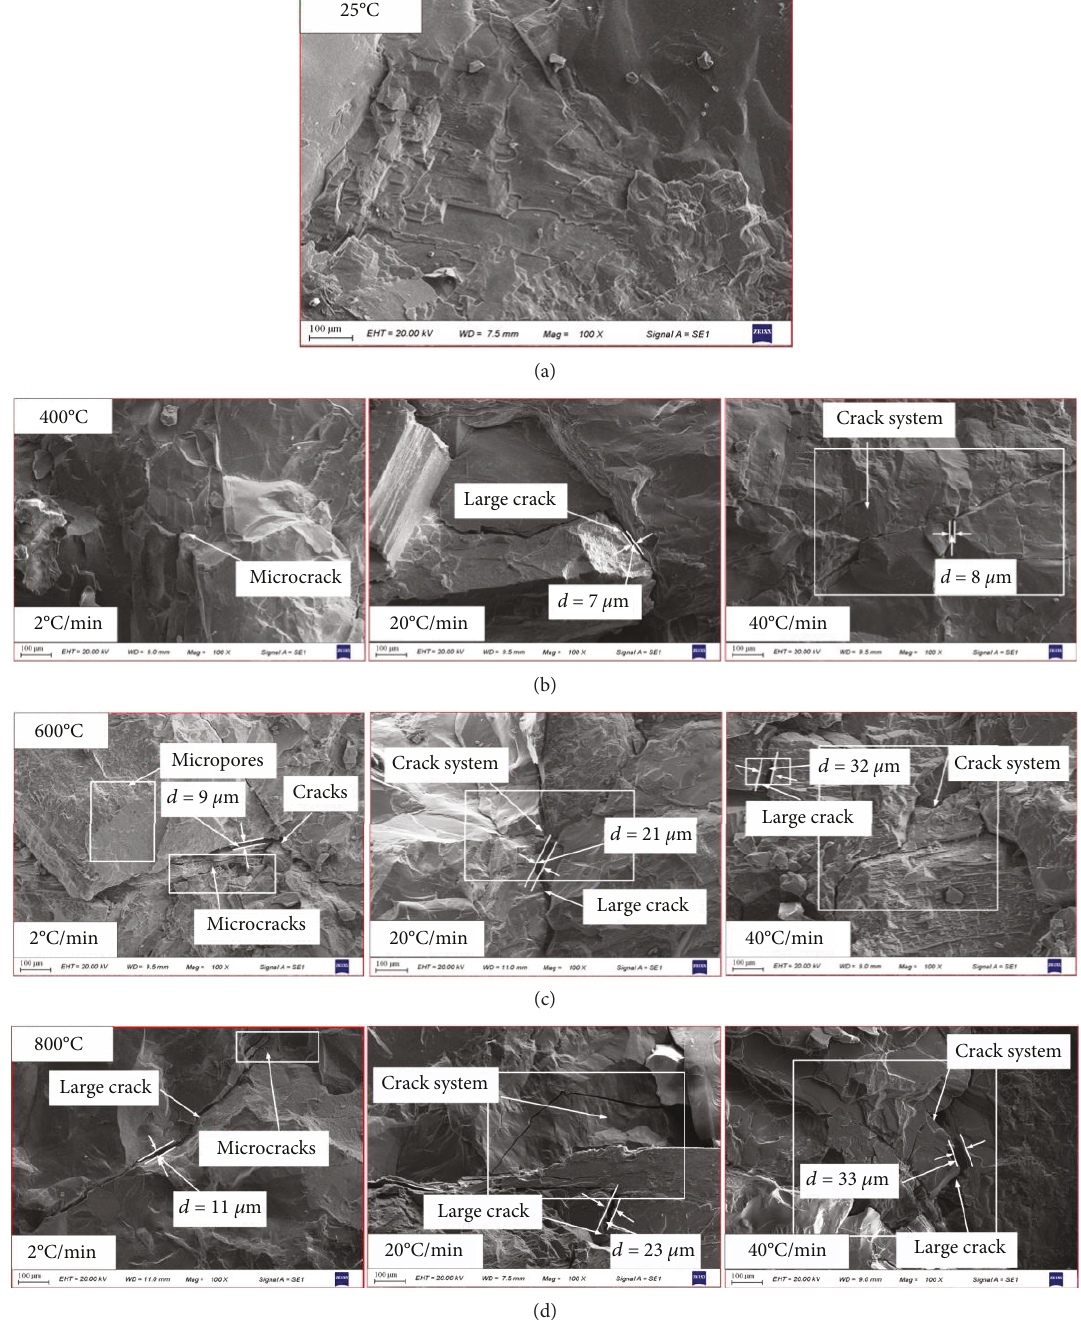
Figure 13: The microstructure of granite samples after treatments at di ff erent heating rates and temperatures: (a) 25 ° C; (b) 400 ° C; (c) 600 ° C; (d) 800 °